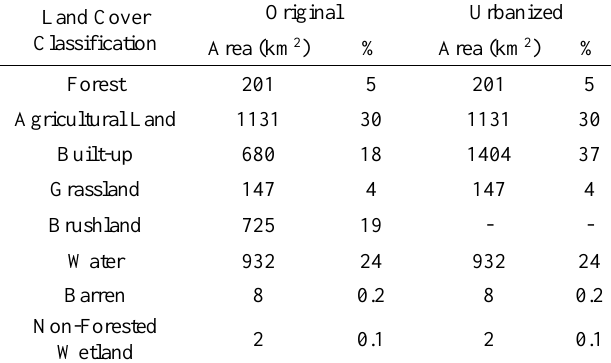
Table 3 . Land Cover Change